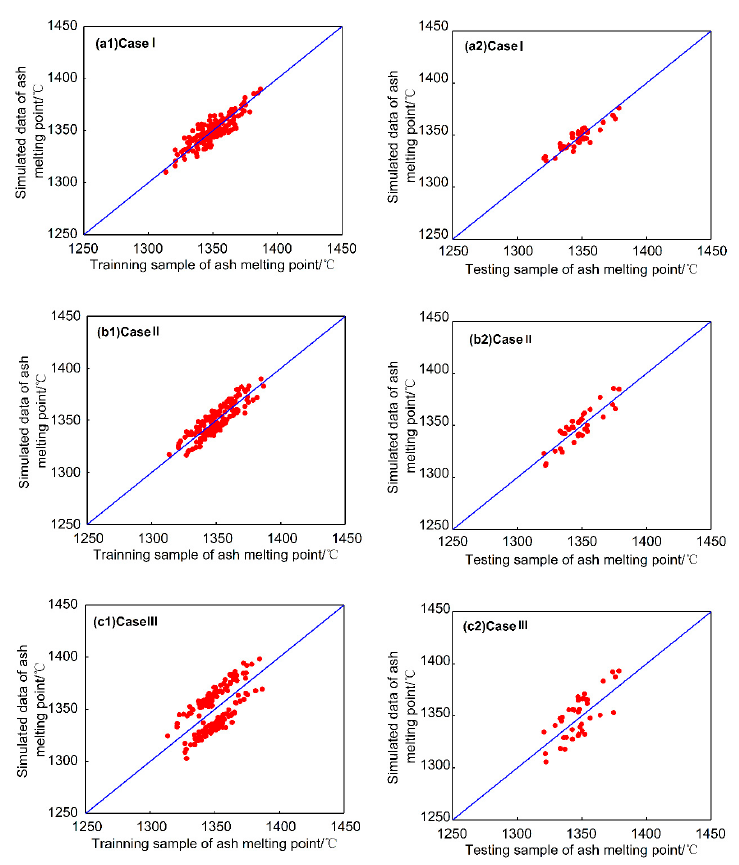
Figure 7. Comparisons of the simulated data and the sample data of AMP in three cases.